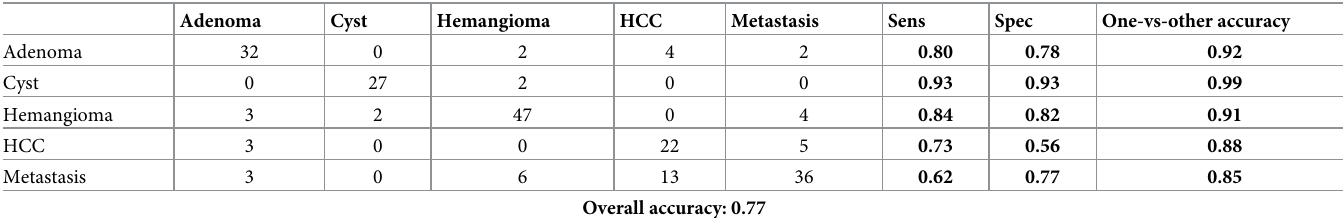
The rows represent the true class and the columns represent the predicted